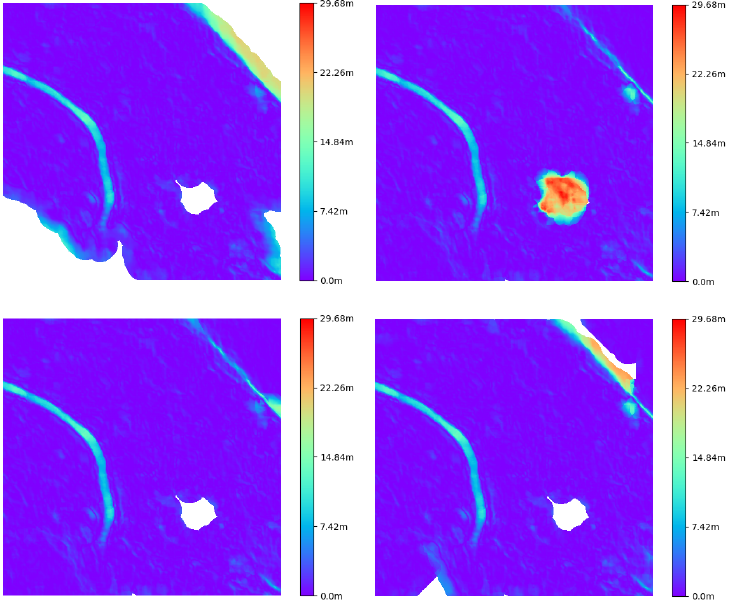
Figure 11. DTMs errors after reclassified as not ground some points (white areas) using the pro- posed methods: ( top left ) One Plane , ( top right ) Uniform , ( bottom left ) Median and ( bottom right ) Surrounding